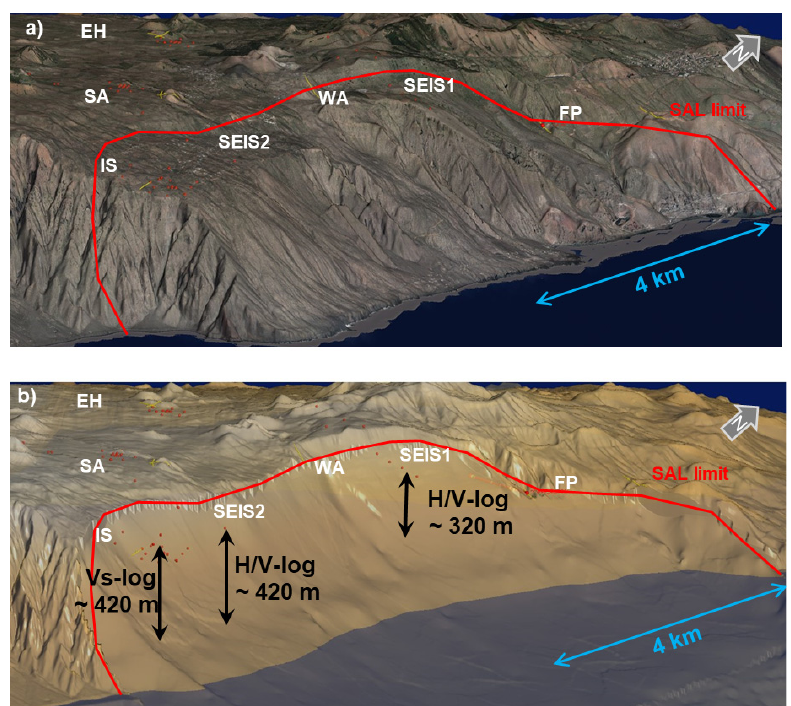
Figure 8. Oblique views (from SE) of the 3D geomodel of the San Andr é s landslide. ( a ) A recent topography with a 0.25 m orthophoto (source [78]); ( b ) the possible sliding surface inferred from the geophysical data analysis (the 20 m DEM-bathymetry with a semi-transparent ocean surface is also shown). The locations of the geophysical field measurement sites are